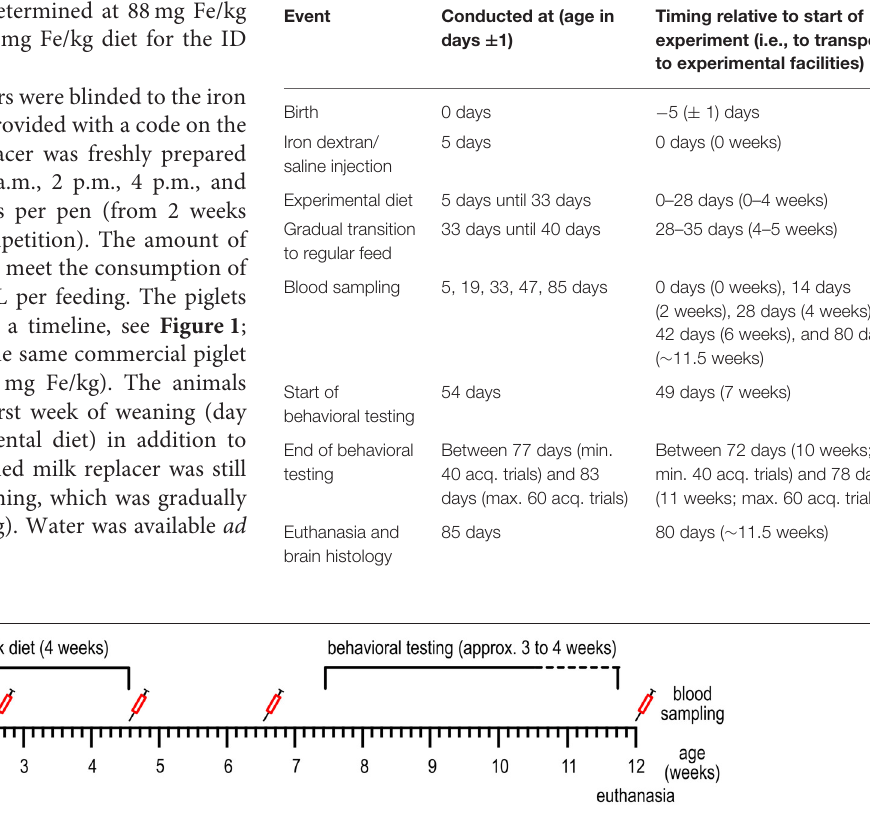
Frontiers in Behavioral Neuroscience |